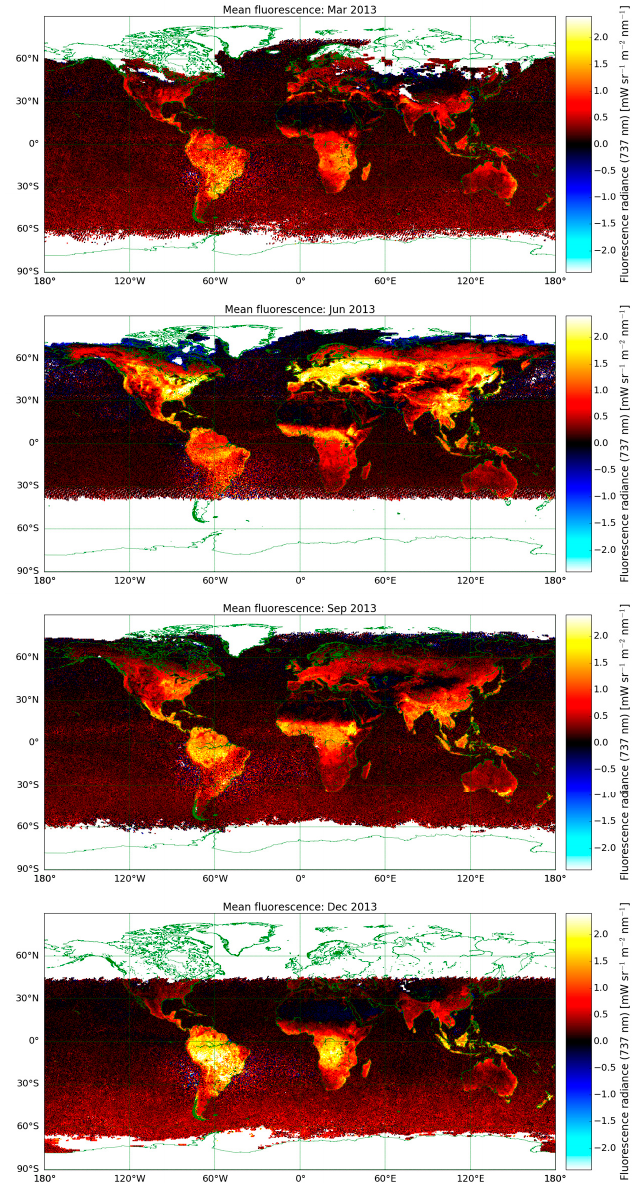
Figure 2. Global maps of monthly mean SiF values at 737 nm for March, June, September and December 2013.